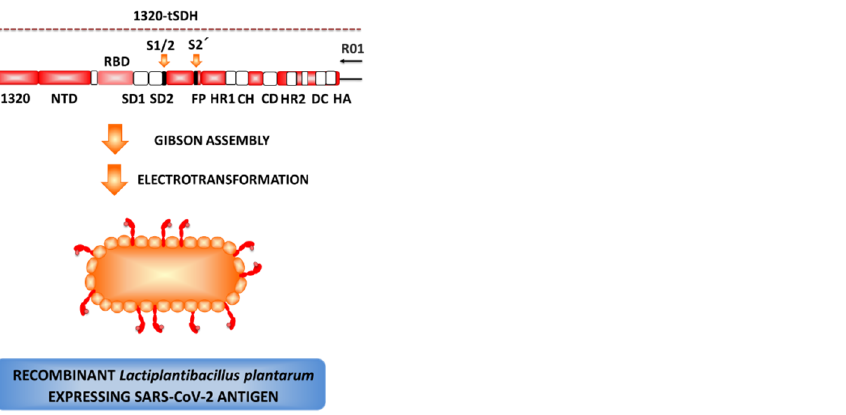
Figure 6. Schematic diagram of the construction of the recombinant Lactiplantibacillus plantarum strain expressing the SARS-CoV-2 spike protein. Modified from Wang et al.